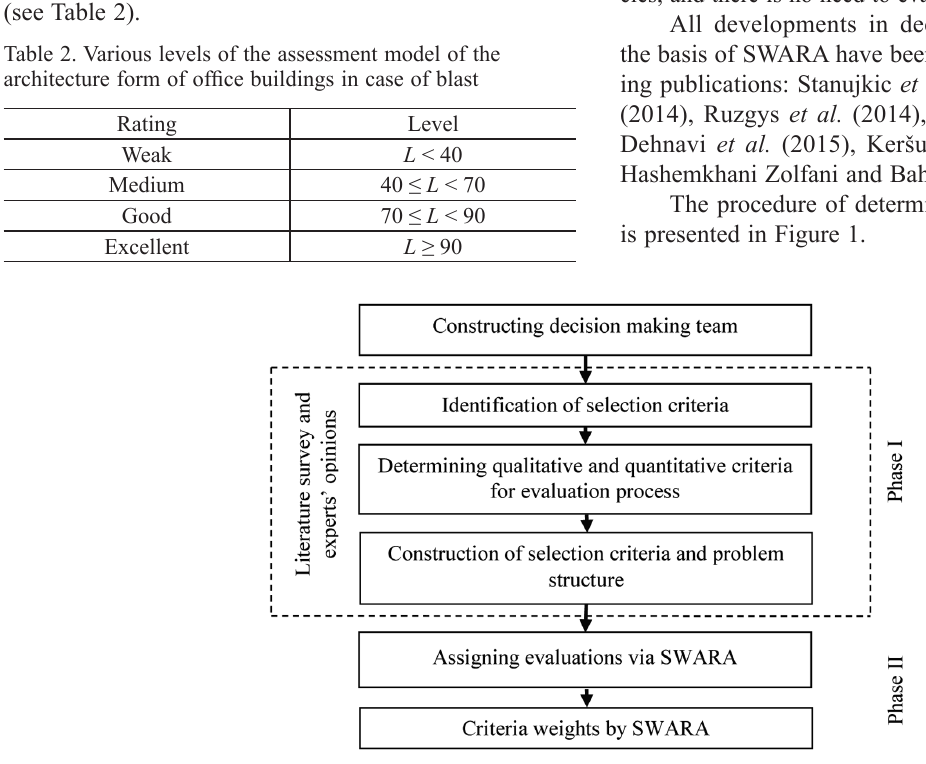
Fig. 1. Schematic display of weighting process of criteria using